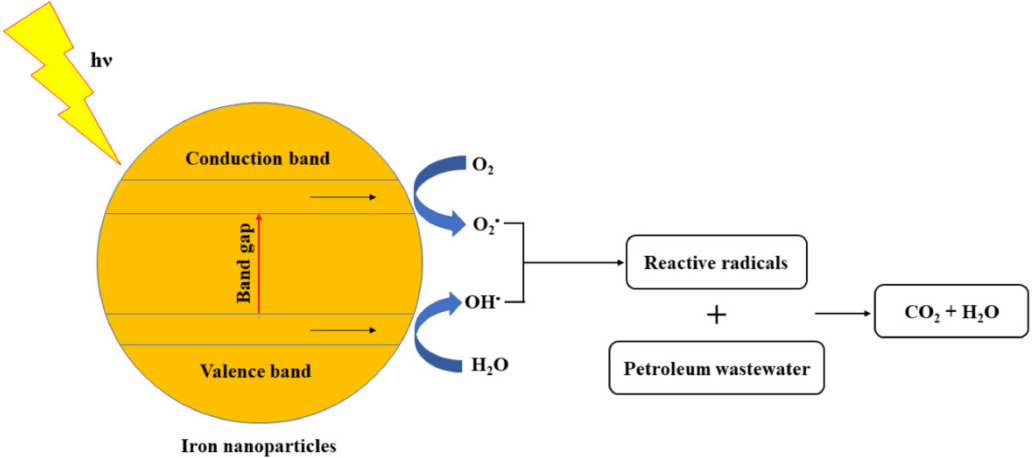
Figure 7. Scheme of the photocatalytic degradation of petroleum wastewater by IONPs/UV system.